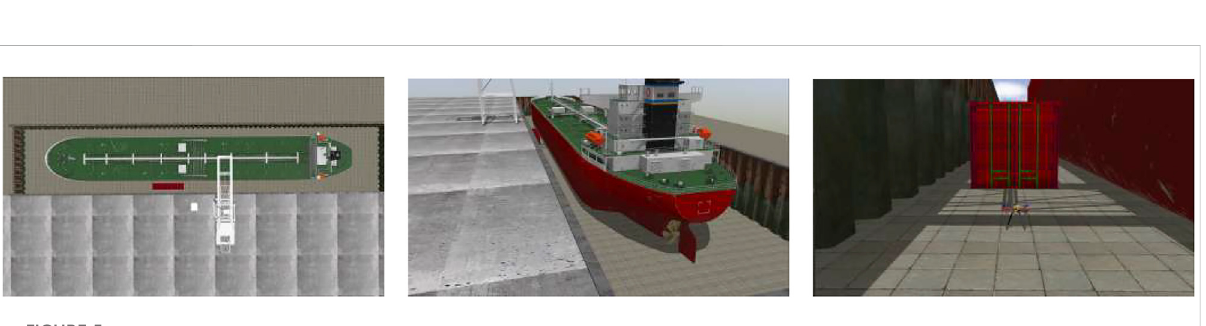
FIGURE 5 Scenario used for evaluation in (Gazebo/ROS)